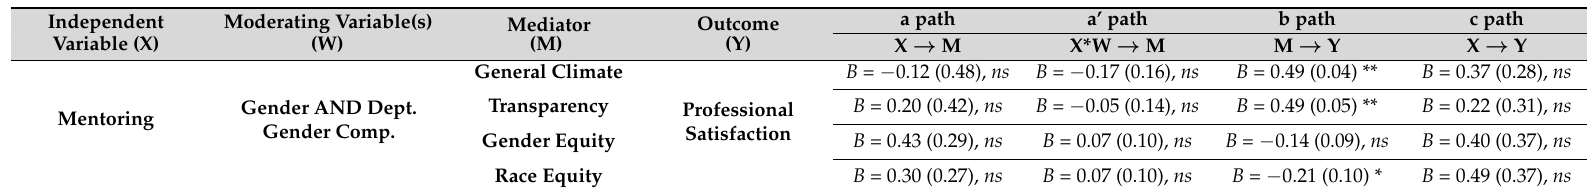
Table 6. Moderated mediation: Effect of mentoring on climate and professional satisfaction, with gender and department gender composition acting as moderating